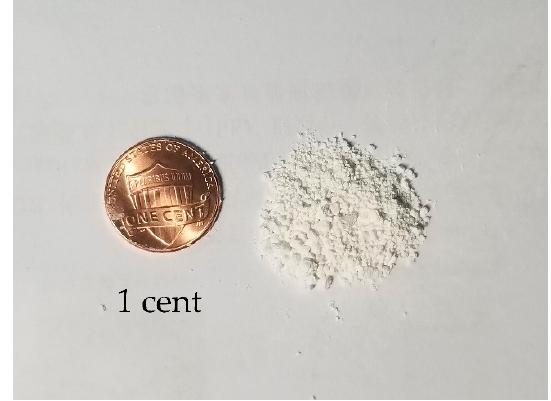
Figure 2. Appearance of nano TiO 2 /CaCO 3 materials.